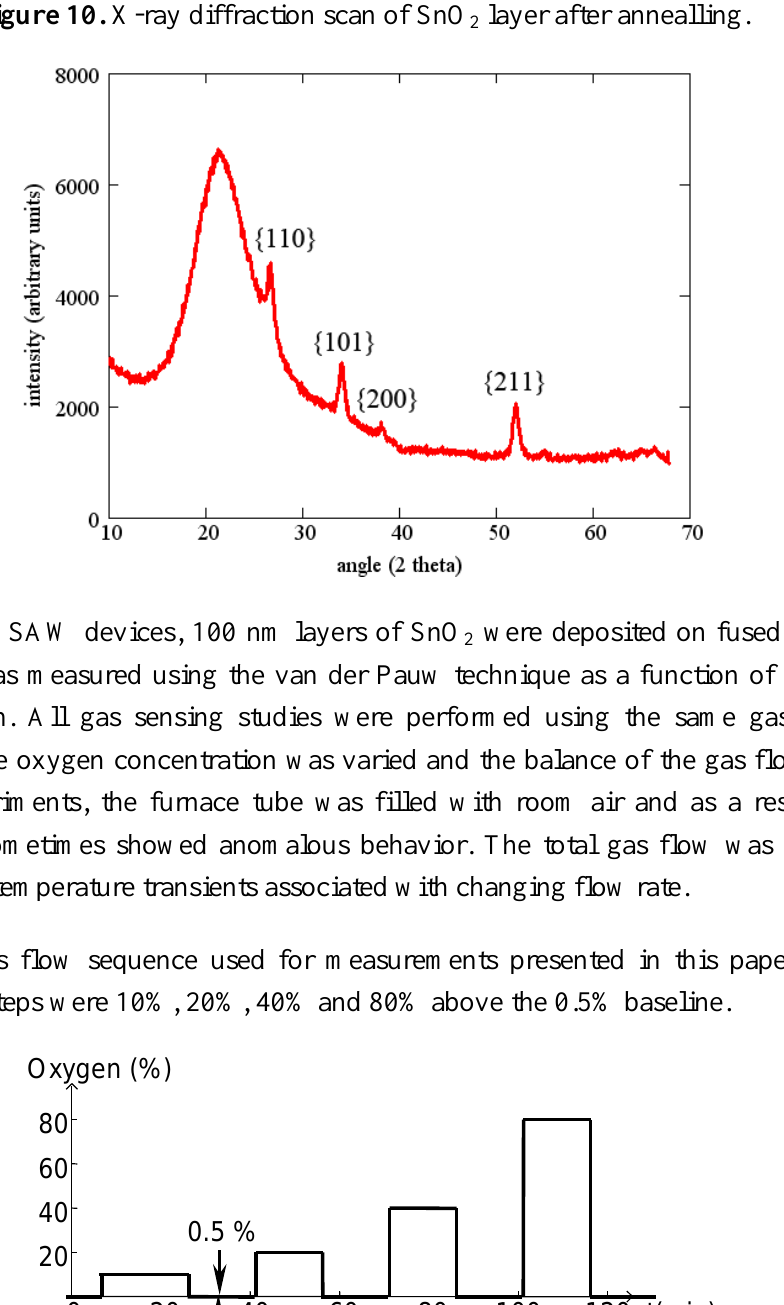
Figure 10. X-ray diffraction scan of SnO